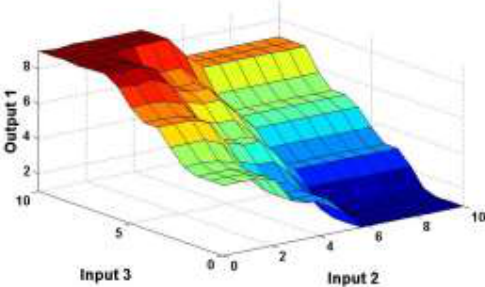
Figure 11. Surfaces of the fuzzy logic subsystem